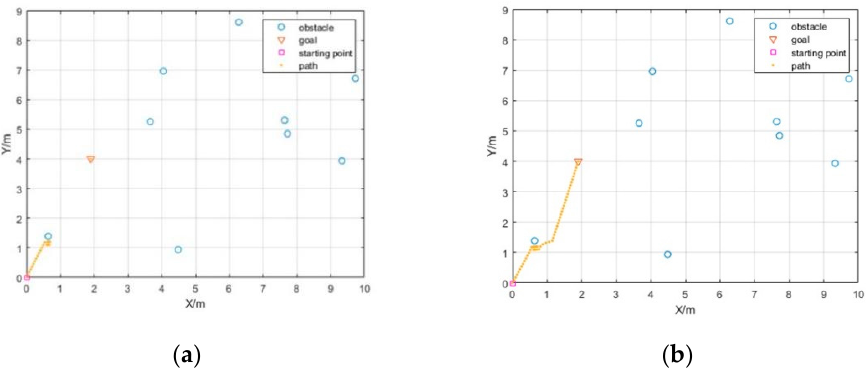
Figure 11. Case 5. ( a ) Traditional artificial potential field method. ( b ) Improved artificial potential field method.